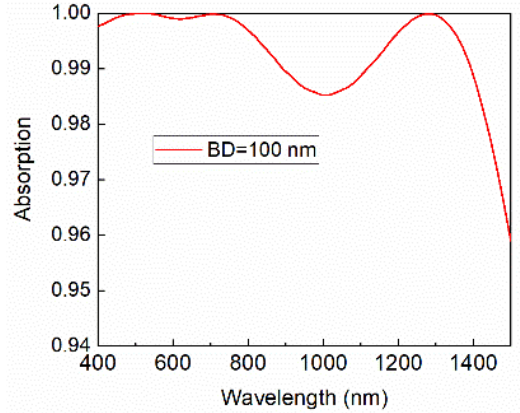
Figure 2. Absorption spectrum of the TiN nanocone MPA.